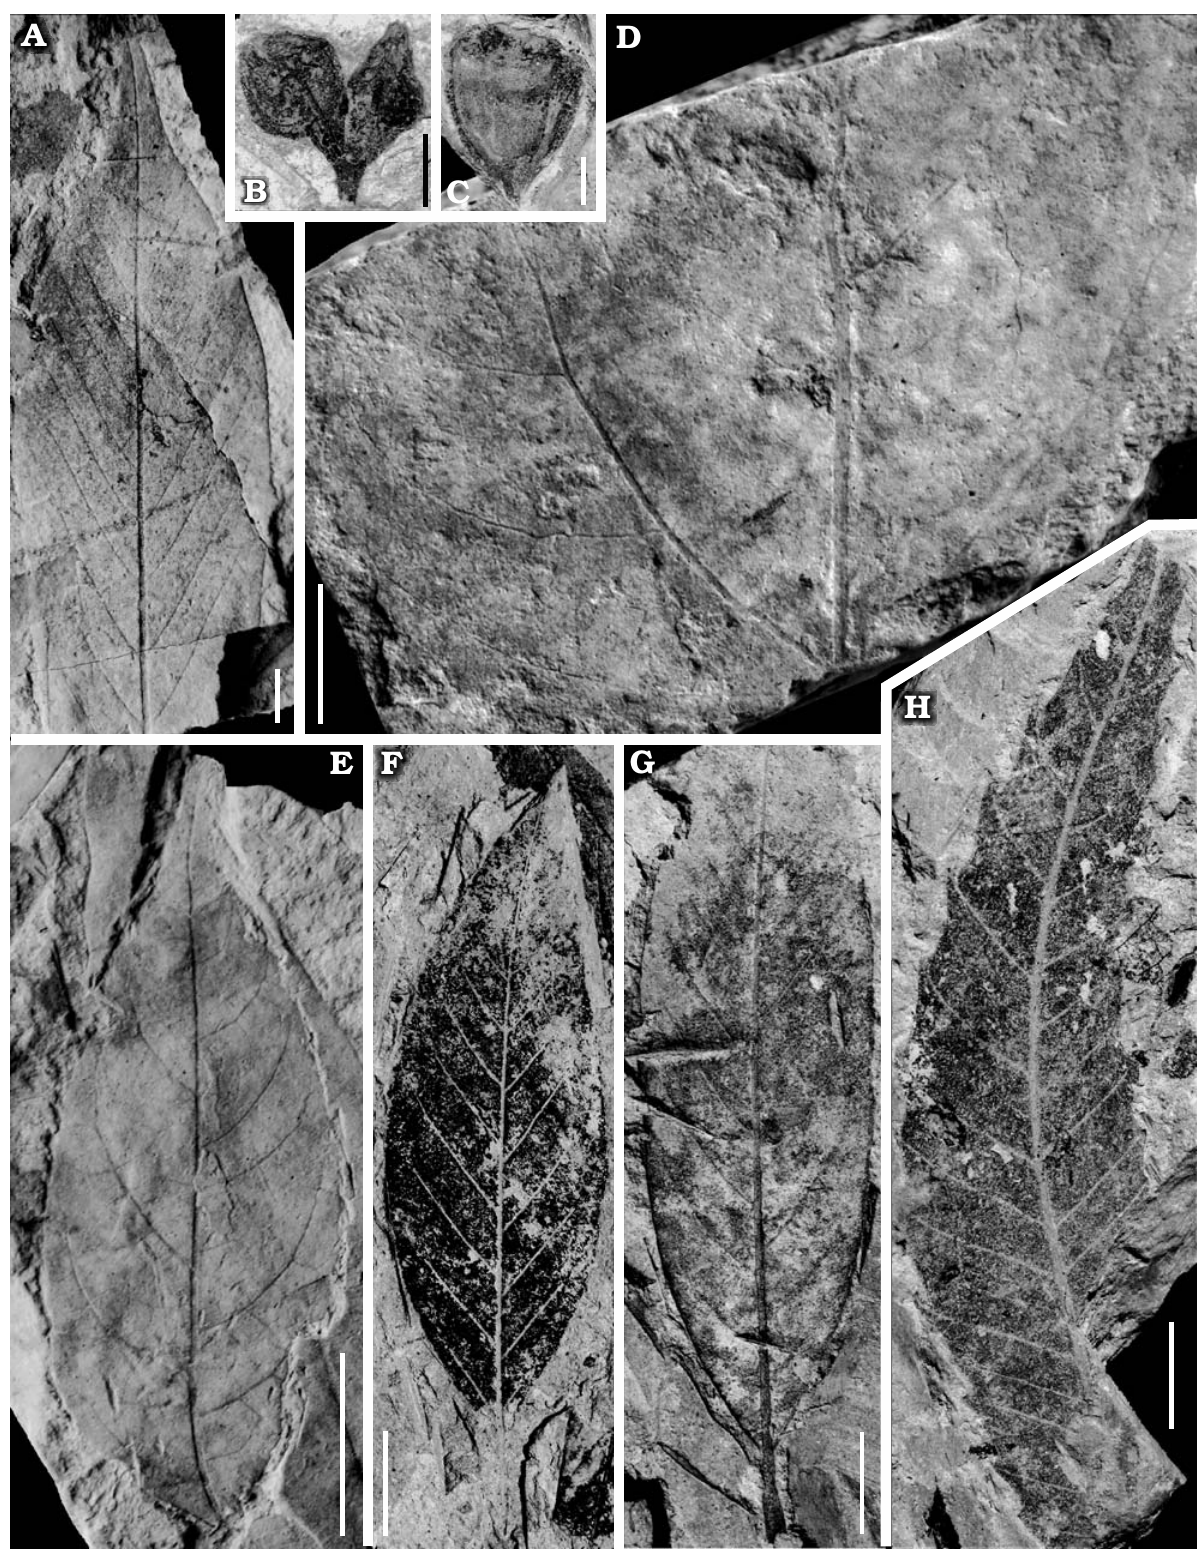
Fig. 6. Angiosperms impressions from Ł ysa Góra near R ę biszów, Poland, late Oligocene. A . cf. Trigonobalanopsis rhamnoides (Rossmässler, 1849) Walther and Kva č ek, 1988, KRAM-P 128/305, leaf. B . Trigonobalanopsis exacantha (Mai, 1970) Kva č ek and Walther, 1988, KRAM-P 128/185, cupules. C . Quercus sp. or Castanopsis sp., KRAM-P 128/313, fruit. D . Populus cf. zaddachii Heer, 1959, KRAM-P 128/511, leaf. E . Sloanea artocarpites (Ettingshausen, 1869) Kva č ek and Hably, 2001, KRAM-P 128/433, leaf. F , G . cf. “ Quercus ” bavarica Knobloch and Kva č ek, 2004, leaves. F . KRAM-P 128/79. G .